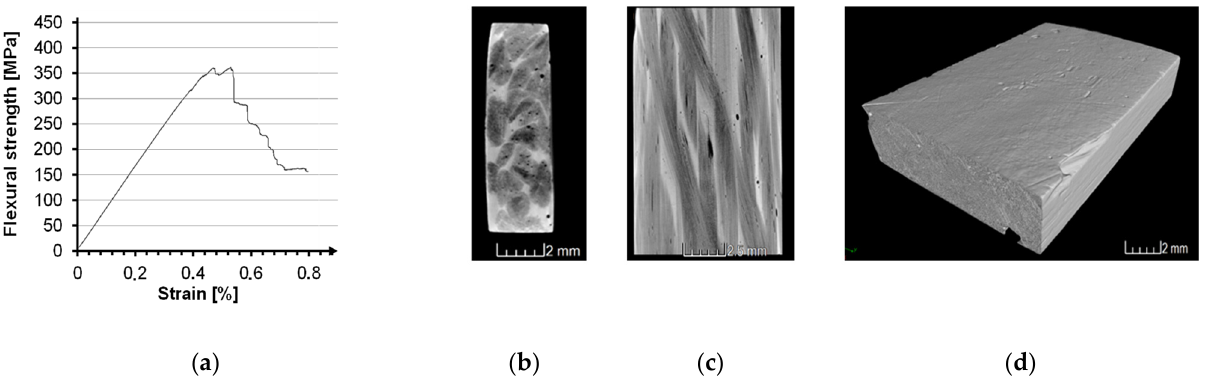
Figure 17. Representative bending stress–strain diagram of a 3D braided OFC ( a ), a µ-CT cross-section of a 3D braided OFC ( b ), a µ-CT plan view of a 3D braided OFC ( c ) and a µ-CT view of a 3D braided OFC ( d ), each of sample 3.